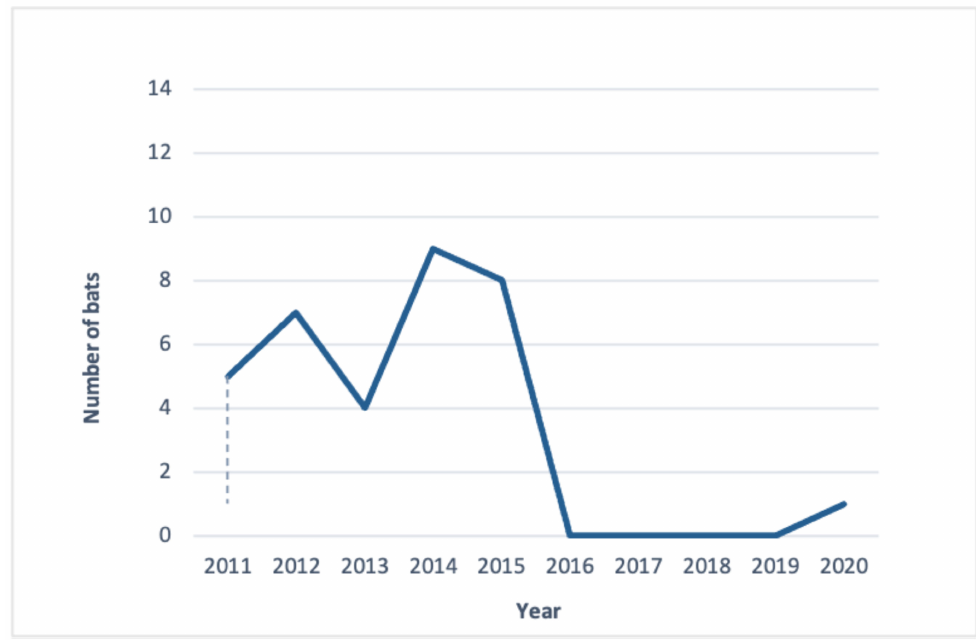
Figure 7. Changes in the number of captures of the pond bat during the autumn swarming season count in the bastions of Fort Carr é of the Wisłouj´scie Fortress in October between 2011 and 2020, indicating a reduction in their numbers to zero, starting from 2016.